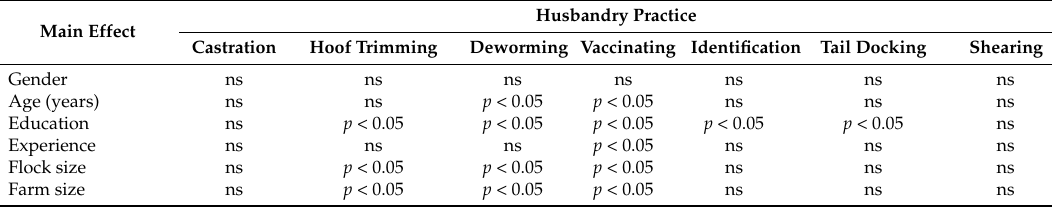
Table 4. Effect of sociodemographic factors on pain perception associated with routine husbandry practices in lambs. Results of the linear regression models testing pain scores for each husbandry